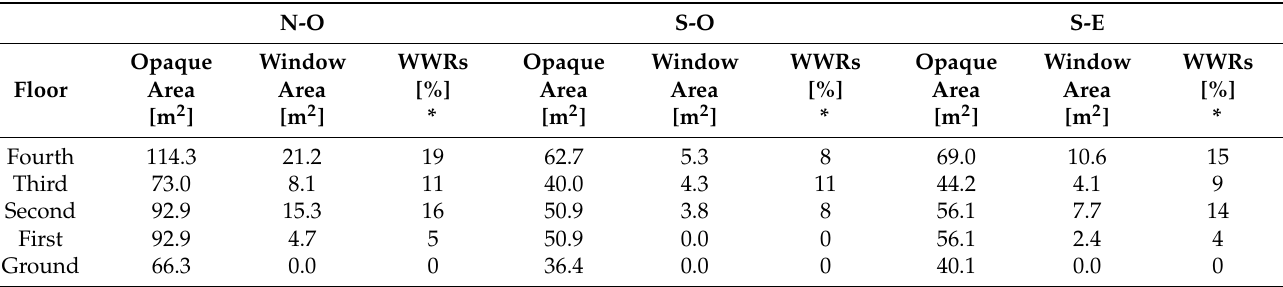
Table 1. Characteristics of the envelope.